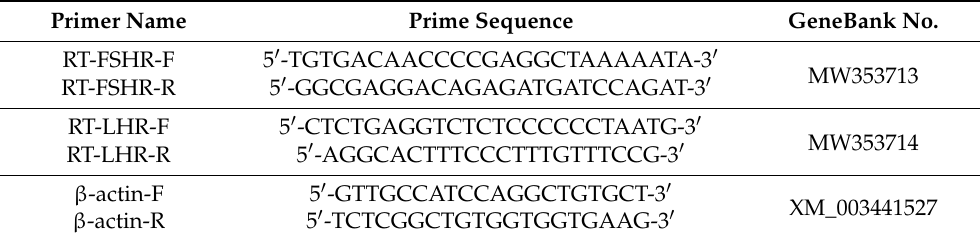
Table 1. Primers used in this